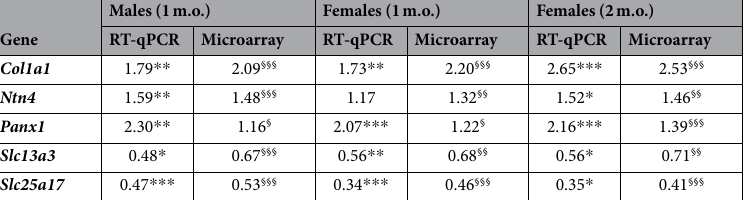
Table 2. Fold change of kidney gene expression in Tg Umod C147W mice relative to age- and sex-matched Tg Umod wt . * P < 0.05; ** P < 0.01; *** P < 0.001 (unpaired t -test). § P < 0.05; §§ P < 0.01; §§§ P < 0.001 (Benjamini Hochberg